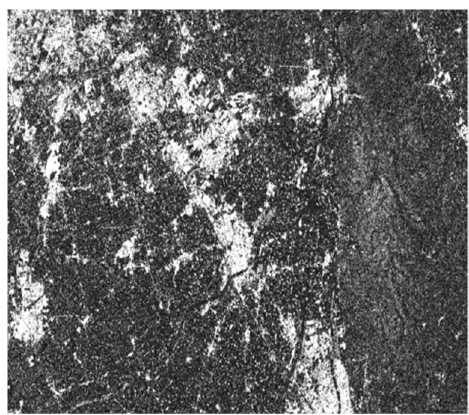
Figure 11. Sentinel-1 coherence map.